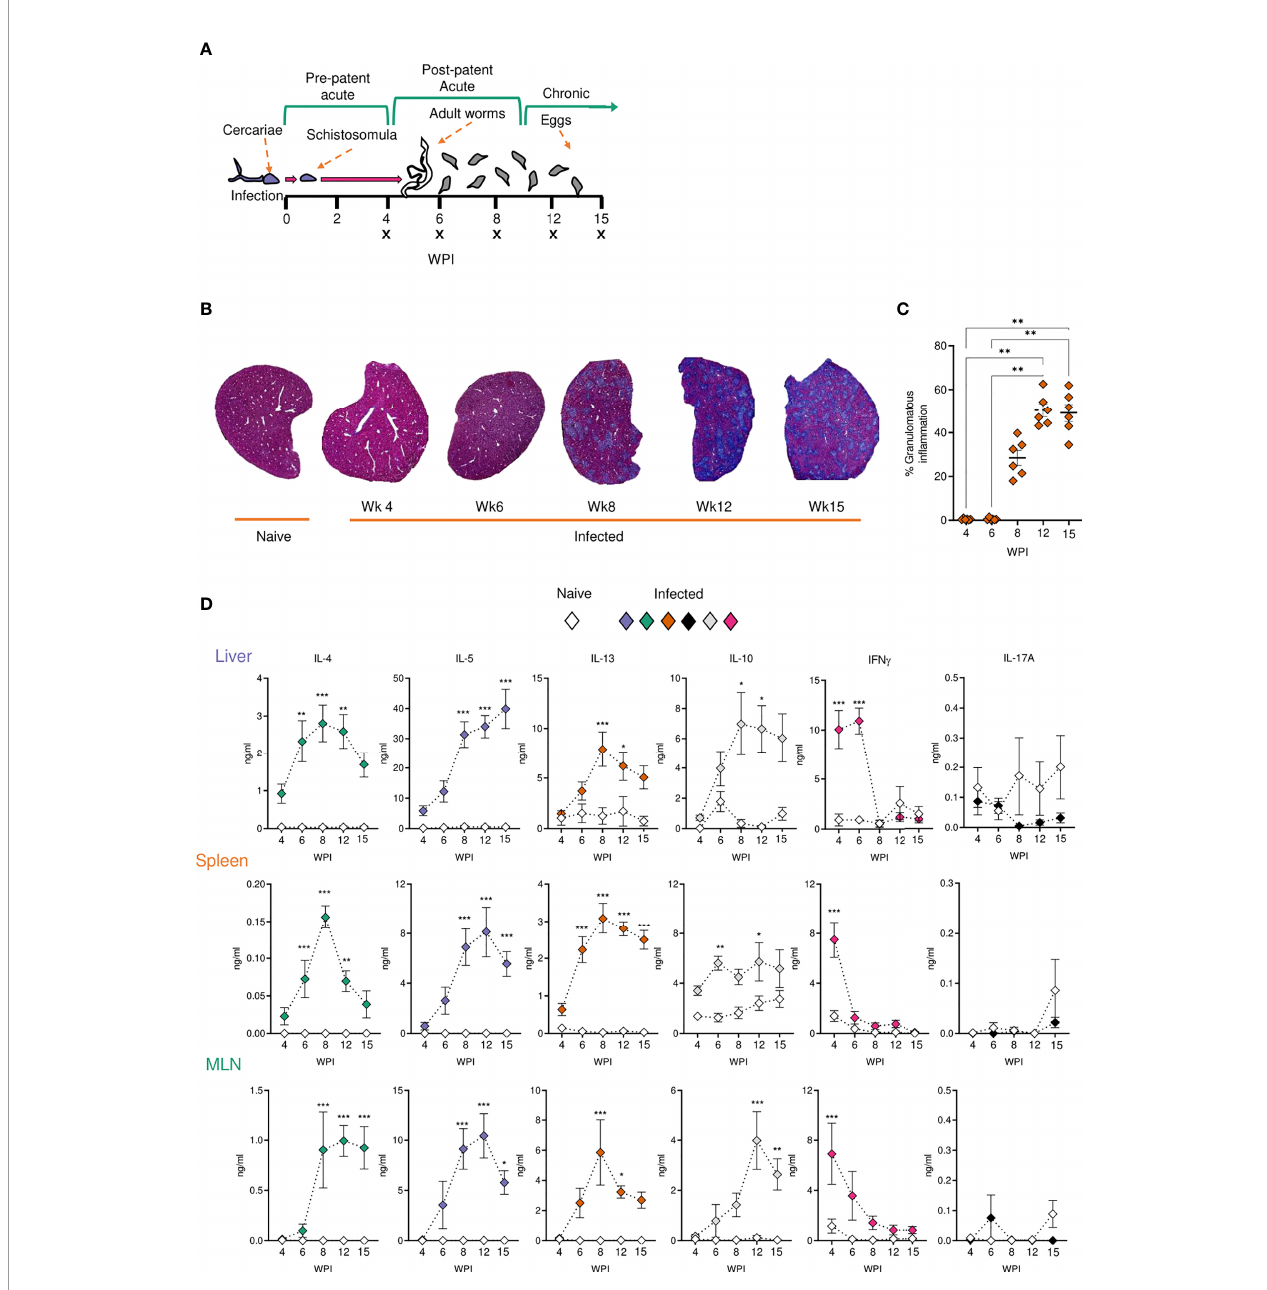
FIGURE 1 | DevelopmentofgranulomatouspathologyandadominantType2responseduring S. mansoni infection. (A) Schematic ofinfectionsetup.C57BL/6micewere infectedwith40 S. mansoni cercariaewithinfectionslasting, 4, 6,8,12or 15wks induration(indicatedbyX). (B) Representative imagesofliversections stainedwithMasson ’ s Trichrome(MT) atindicatedwks, allowingfor visualisationofin fl ammatorycellin fi ltrationandtypeIcollagendeposition. (C) Theproportionofgranulomatous in fl ammationper tissuesection, usinganobjectivealgorithm to quantifythenumber ofpixels ofgranulomatousin fl ammationinade fi nedregionofinterest. (D) Atspeci fi edwks, liver,spleenand MLNcellsfrom naïveandschistosomeinfectedmicewereculturedfor72hwith0.25 µgofschistosomeegg antigen(SEA;antigen-speci fi cstimulation). Supernatantswere collectedandcytokineproduction(medium alonevaluessubtracted)wasassessedbyELISA.Dataarefrom asingleexperiment (B, C) or pooledfrom 2 (D) separateexperiments (n=36-10animalsper time point). Signi fi cancecalculatedbyone-way (C) or two-wayANOVA (D) .Datapresentedasmean+/-SEM. *p< 0.05,**p<0.01, ***p<